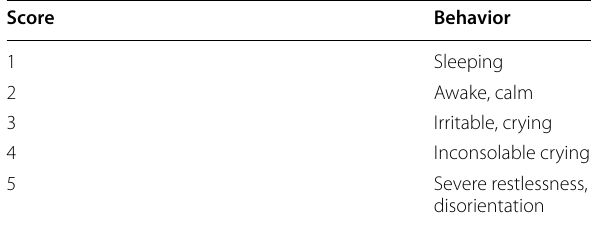
Table 1 Cole scoring system for emergence agitation